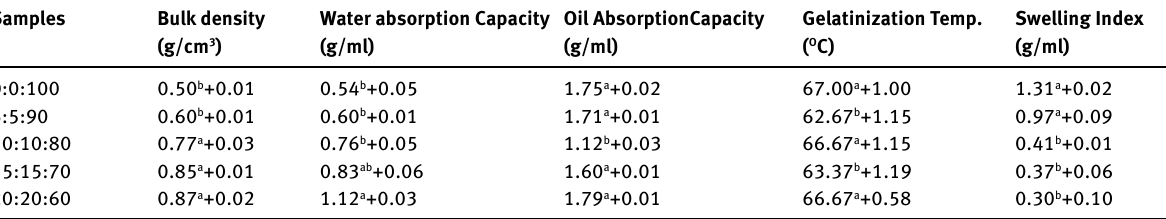
Table 1: Functional Properties of the Composite Flours